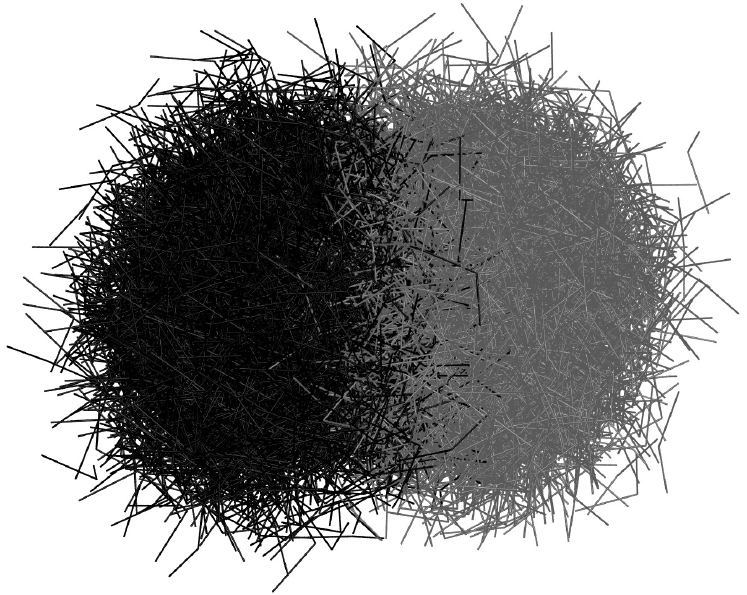
Figure 3. 10,000 snapshots for two neighbouring relabeled molecules from the dynamics are shown in gray and black,